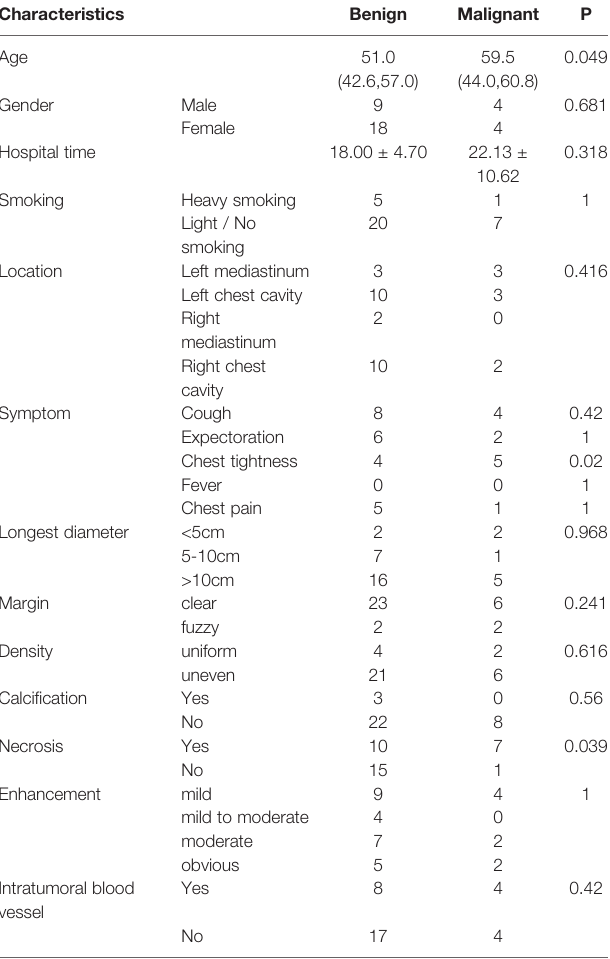
TABLE 2 | Comparison between benign and malignant SFTP patients.